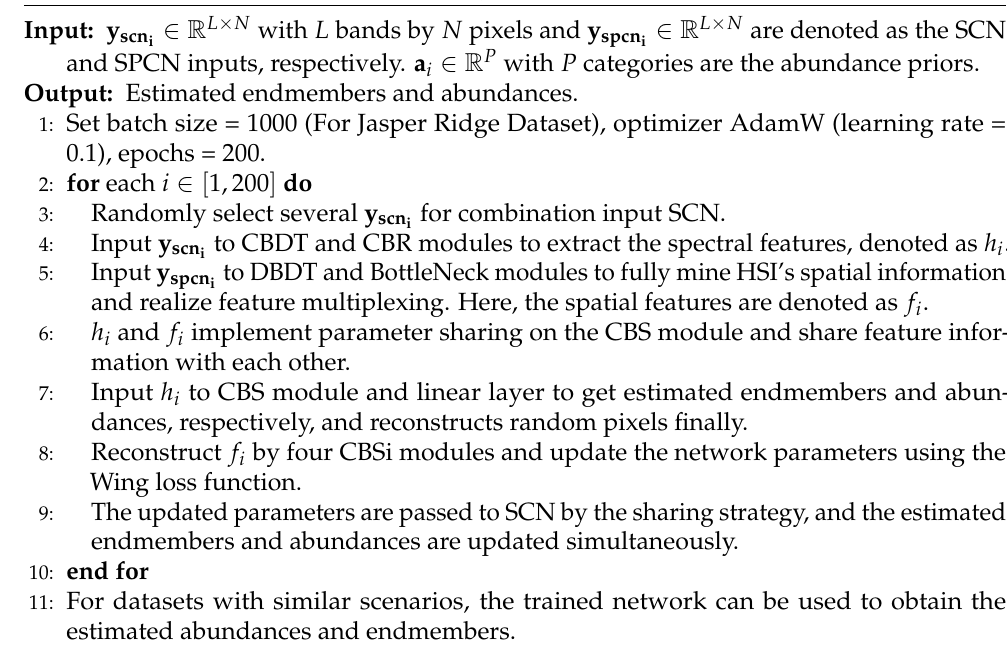
Algorithm 1 SISLU-Net for HSI